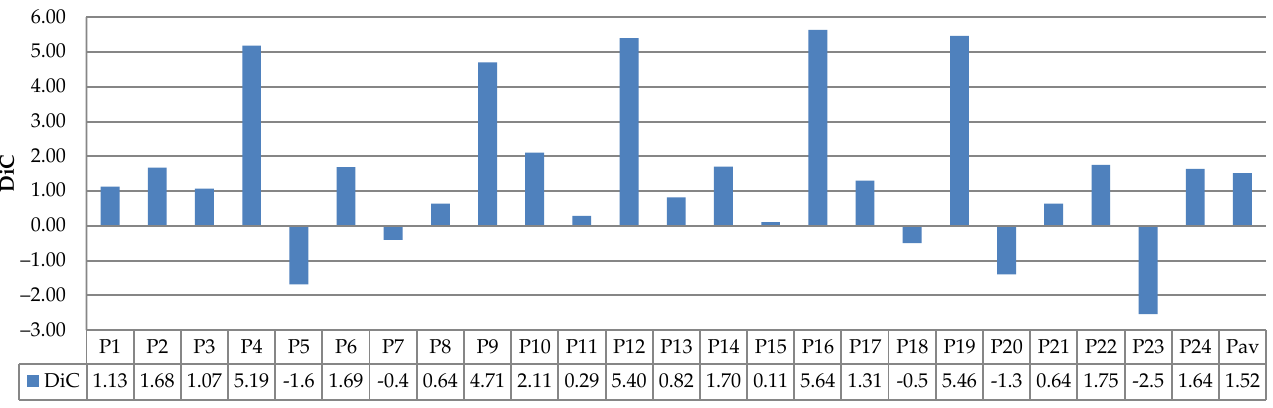
Figure 24. Results of DiC measurements using Ara2013.